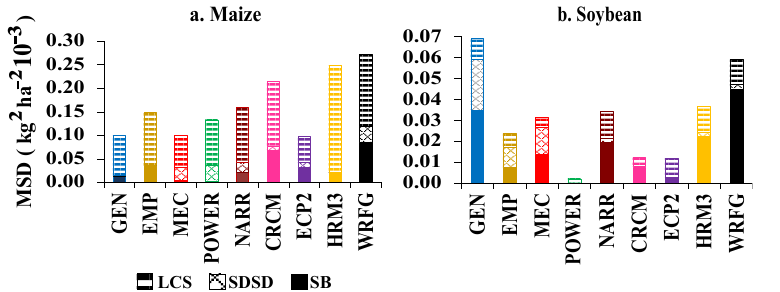
Figure 13. Soybean yield (kg ha −1 ) for the eight-­‐‑year analysis period simulated using daily solar radiation observations and estimates as input to CROPGRO−Soybean. OSR and ESR refer to observed and estimated solar radiation, respectively. Note: the simulated yields for the empirical and the mechanistic models were combined for the calibration and validation periods.